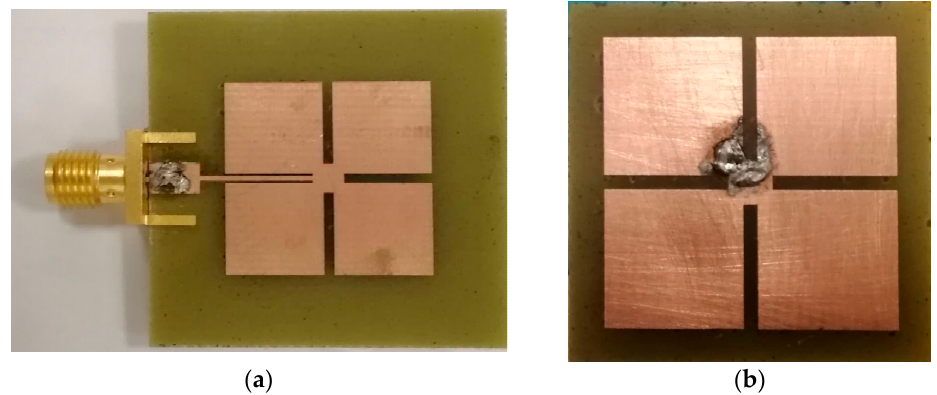
Figure 17. Photographs of the slotted square patch antenna in the ( a ) single-band and ( b ) dual-band.